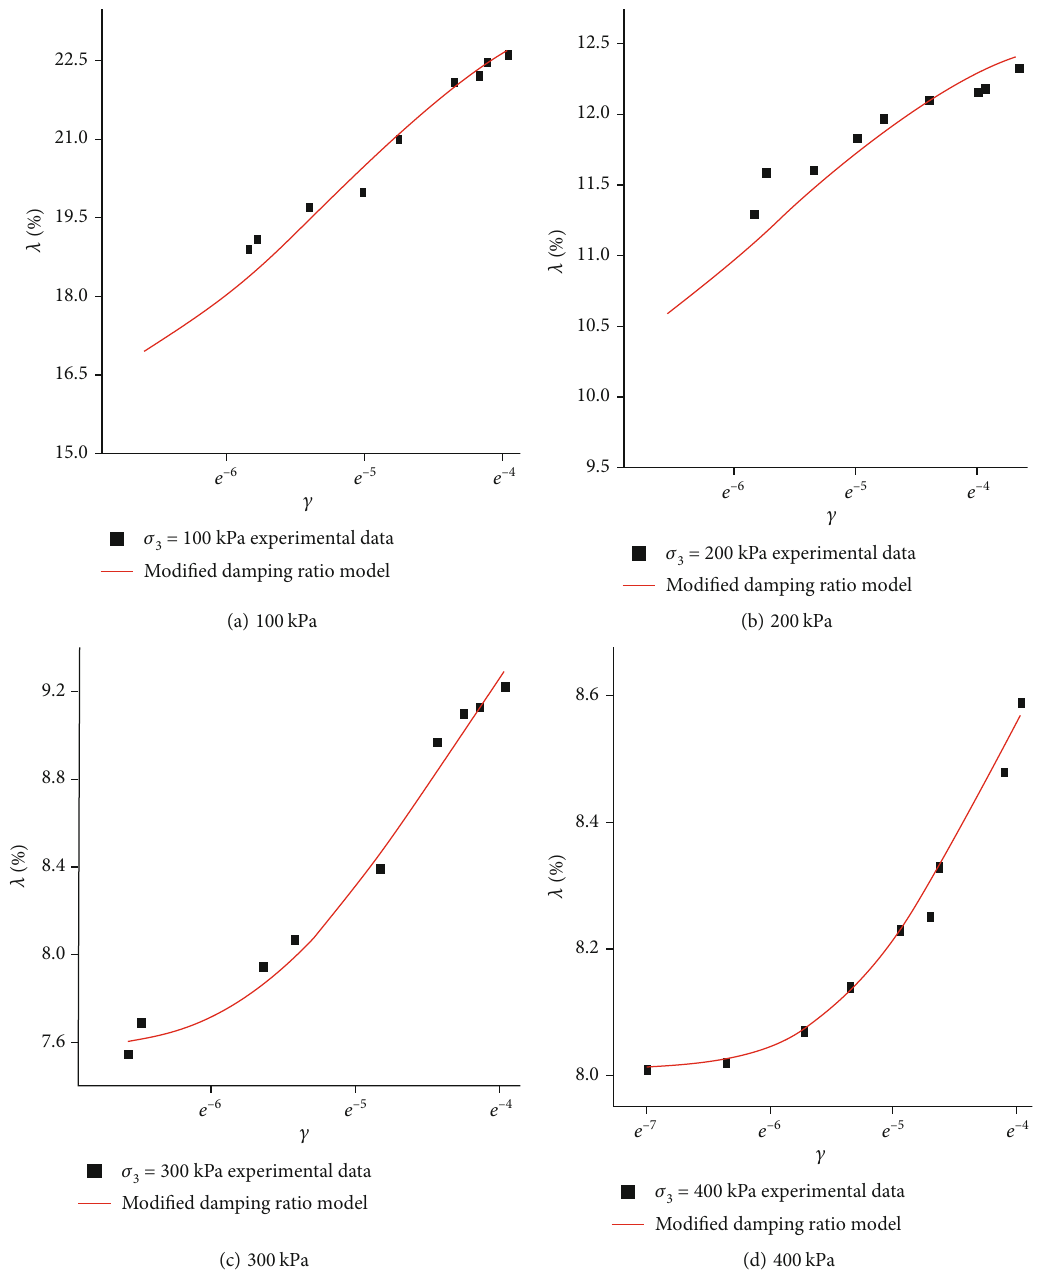
Figure 13: Comparison diagram of λ ~ γ fi tting for calcareous sand under di ff erent e ff ective con fi ning